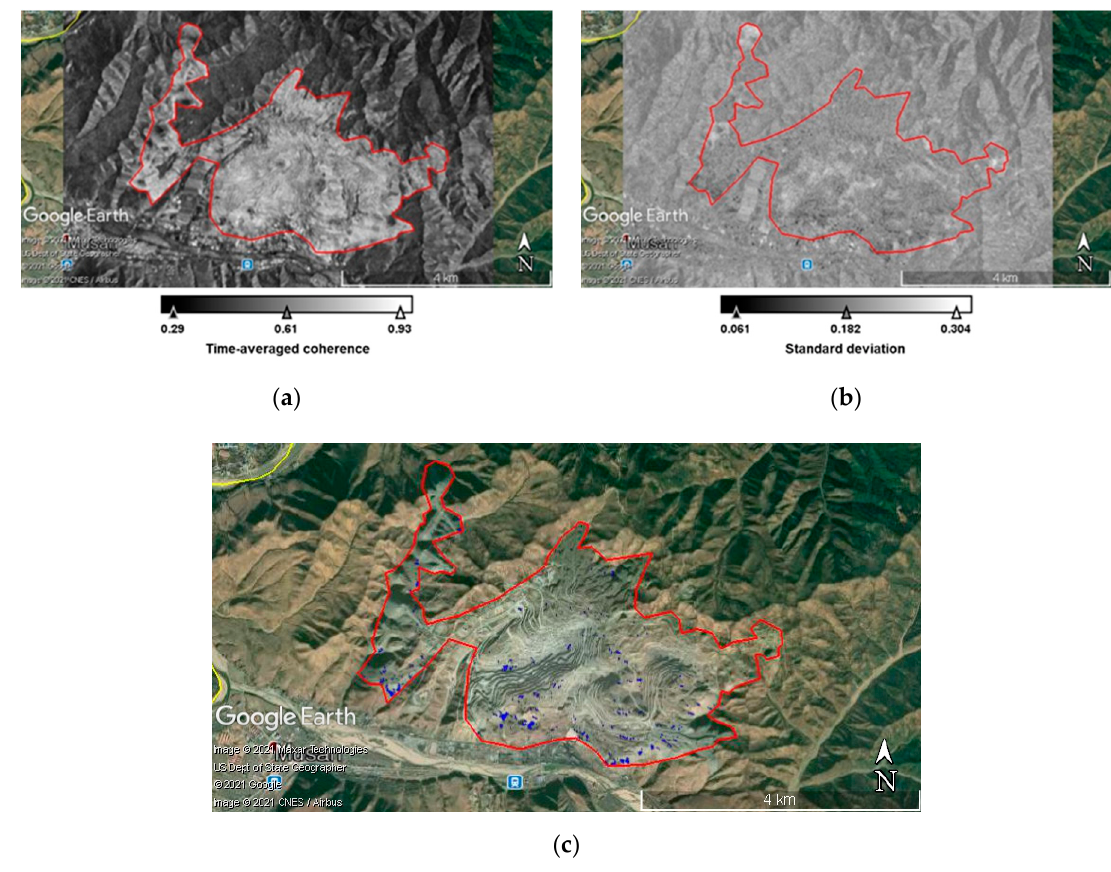
Figure 5. Selection process of stable points. ( a ) Time-averaged coherence image. ( b ) Standard deviation image. ( c ) Stable points in blue color. The red polygon is the mining area, the region of interest.